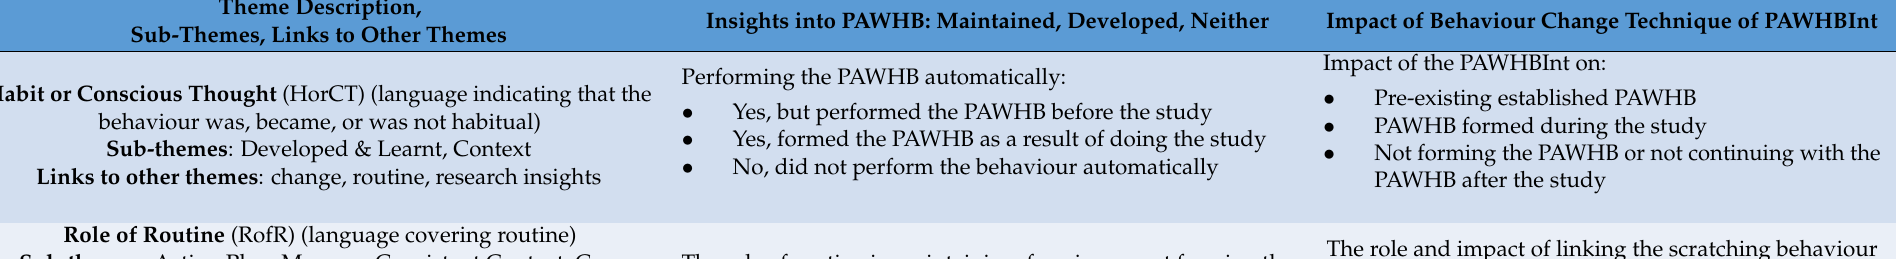
Table 1. Overview of themes and the inquiry of their relation to the research question (*[31]). Abbreviations: HorCT—habit or conscious thought; RofR—role of routine; AF—animal feedback; C&I—change & intention; PAWHB—pro-animal welfare habitual behaviour;—pro-animal welfare habitual behaviour